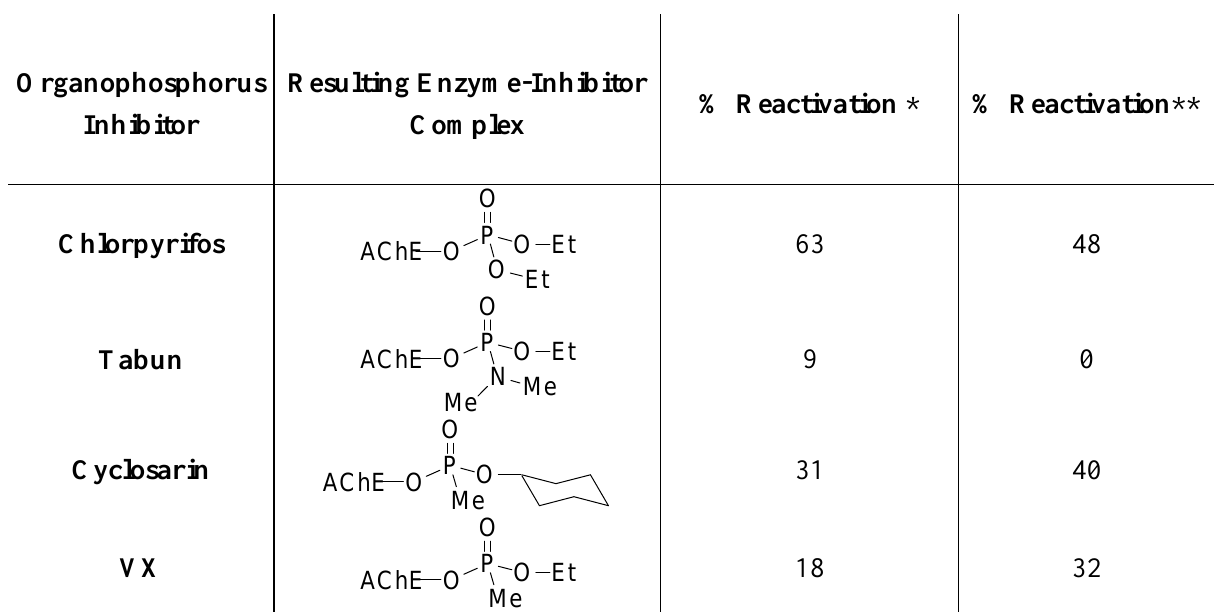
Table 1. Reactivation of nerve agent-inhibited AChE by reactivator K053 ( 3 ) (source of the enzyme – rat brain acetylcholinesterase; time of inhibition by nerve agent – 30 min; time of reactivation – 10 min; pH – 7.6;